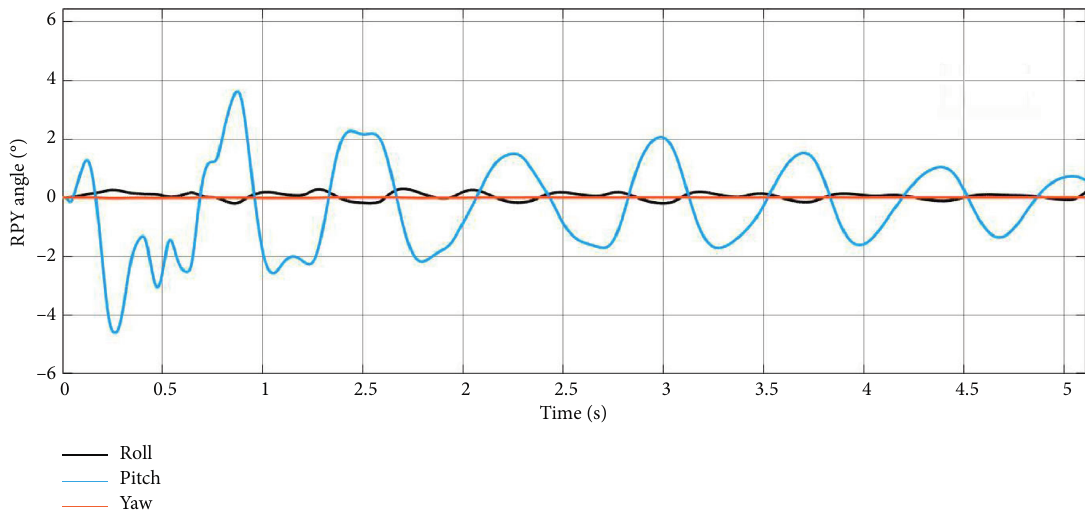
Figure 10: RPY output response curve of PID controller between 0 and 5